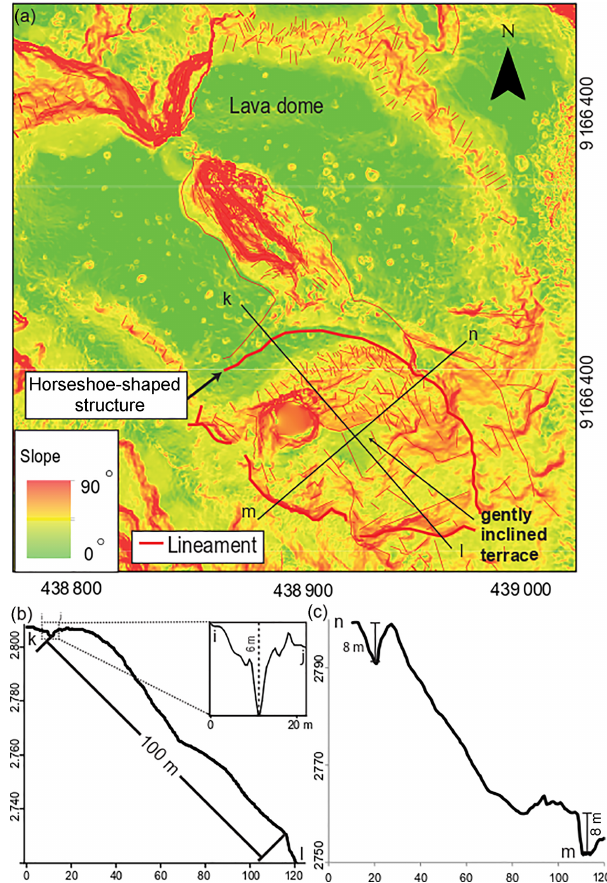
Figure 3. (a) Detailed slope map of the Merapi lava dome that shows that the top of the dome is relatively flat. The fissure and the northern part of the dome are steeply inclined with a slope of ≥ 80 ◦ . The southern block possibly consists of two different flow units which are separated by a gently inclined terrace. A cross sec- tion of the lines (b) k-l and (c) m-n that shows that the horseshoe- shaped structure has a maximum depth of